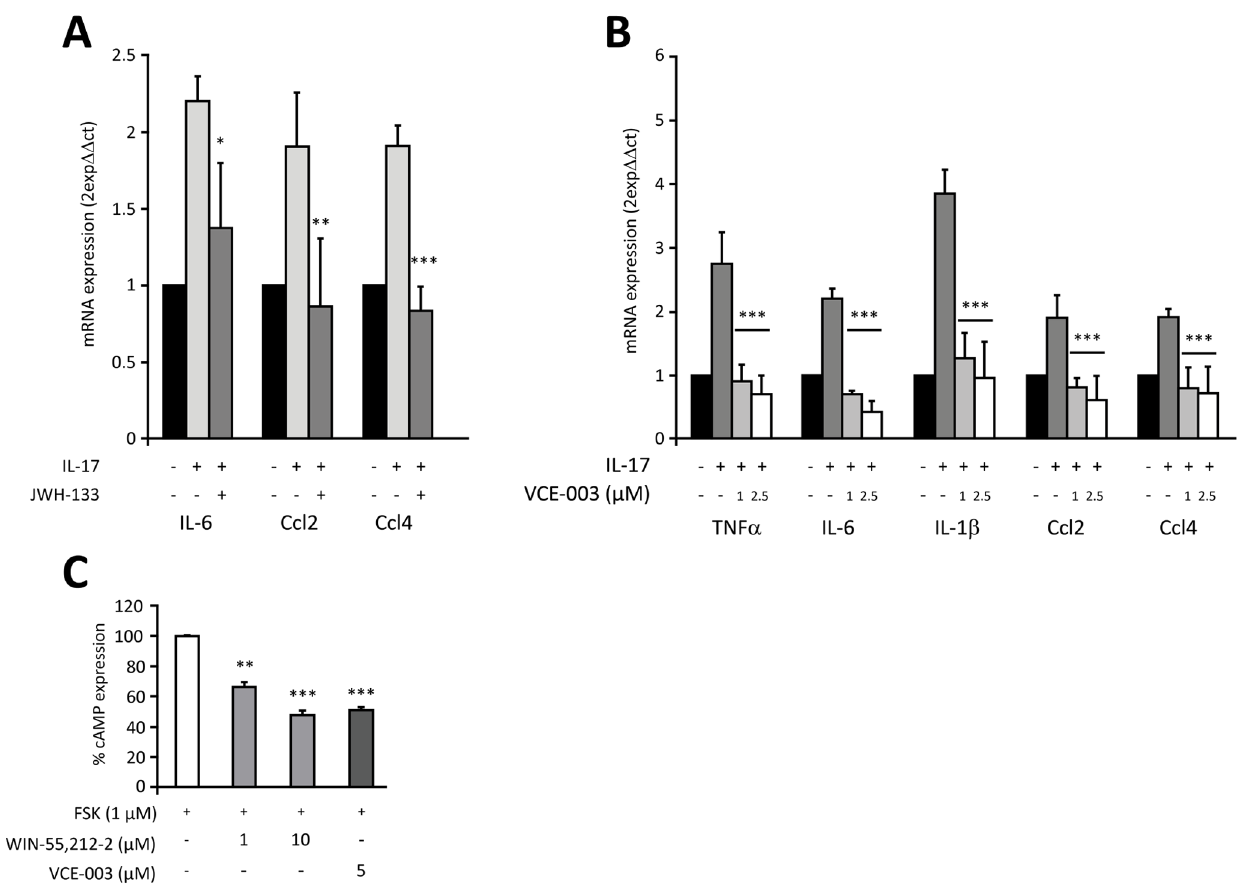
Figure 3. VCE-003 and JWH-133 reduces IL-17-induced M1 polarization in macrophages. Serum starved RAW264.7 cells were exposed to either JWH-133 (5 m M) or VCE-003 (1 and 2.5 m M) for 18 h and then maintained for 24 h in the presence or absence of recombinant mouse IL-17 (50 ng/ml). A) RT-PCR analysis of M1 gene expression in JWH-133-treated RAW264.7 cells. B) RT-PCR analysis of M1 gene expression in VCE-003- treated RAW264.7 cells. The results are expressed as the fold change with respect to untreated cells and they are the mean 6 SEM of four independent experiments. C) CHO-CB2 cells were transiently transfected with the CRE-luc plasmid and then exposed to FSK (1 m M) for 6 h in the presence or absence of the indicated concentrations of WIN-55,212-2 (1 or 10 m M) and VCE-003 (5 m M) before luciferase activity was measured in the cell lysates. The results are expressed as the means 6 SEM of three determinations and they are expressed as the percentage inhibition considering FSK stimulation as 100% activation: *p , 0.05, **p , 0.01 and ***p , 0.005 in an unpaired two-tailed Student’s t